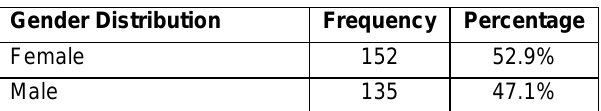
Table 1. Characteristics of